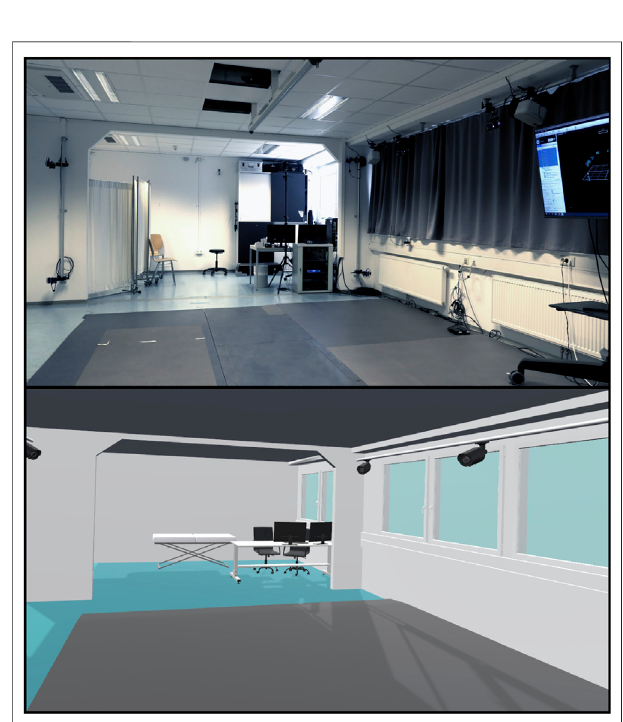
FIGURE 2 | The real-world laboratory (upper picture) compared to the virtual environment resembling the real-world (lower picture) participants walked through when wearing the